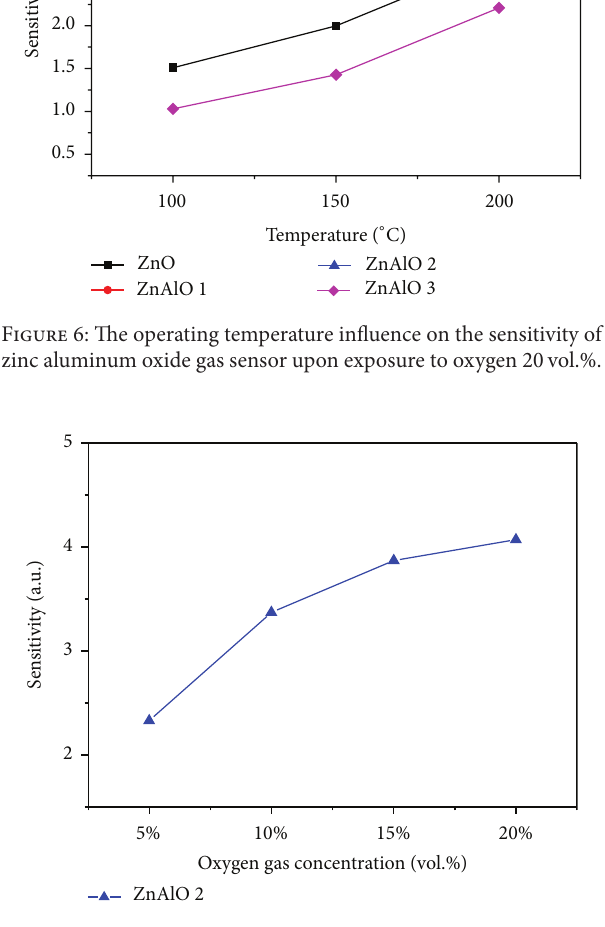
Figure 7: Oxygen concentration influence on the sensitivity of zinc aluminum oxide (ZnAlO 2) gas sensor at an operating temperature of 200 ∘